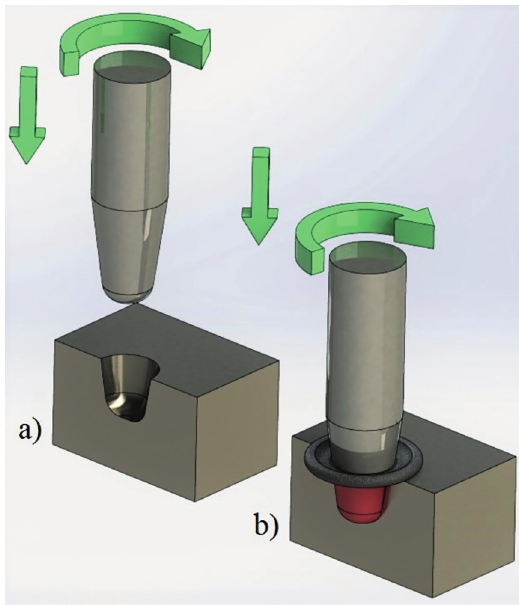
Figure 1: Schematic illustration showing FHPP process. a) Rotating consumable plug co-axially, b) processing and pressed against structure.